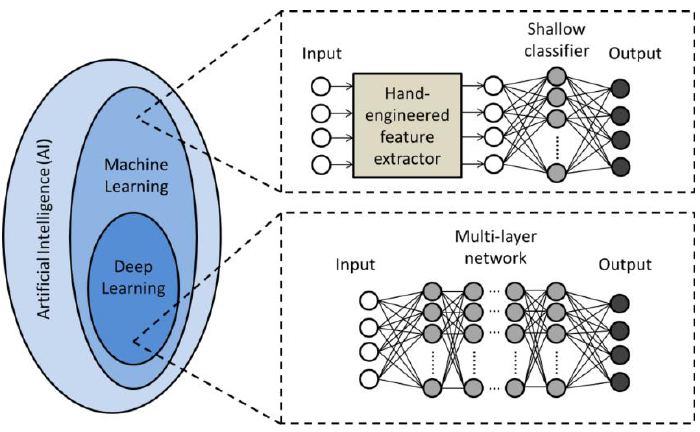
Figure 3. Relationship between AI, machine learning and deep learning.